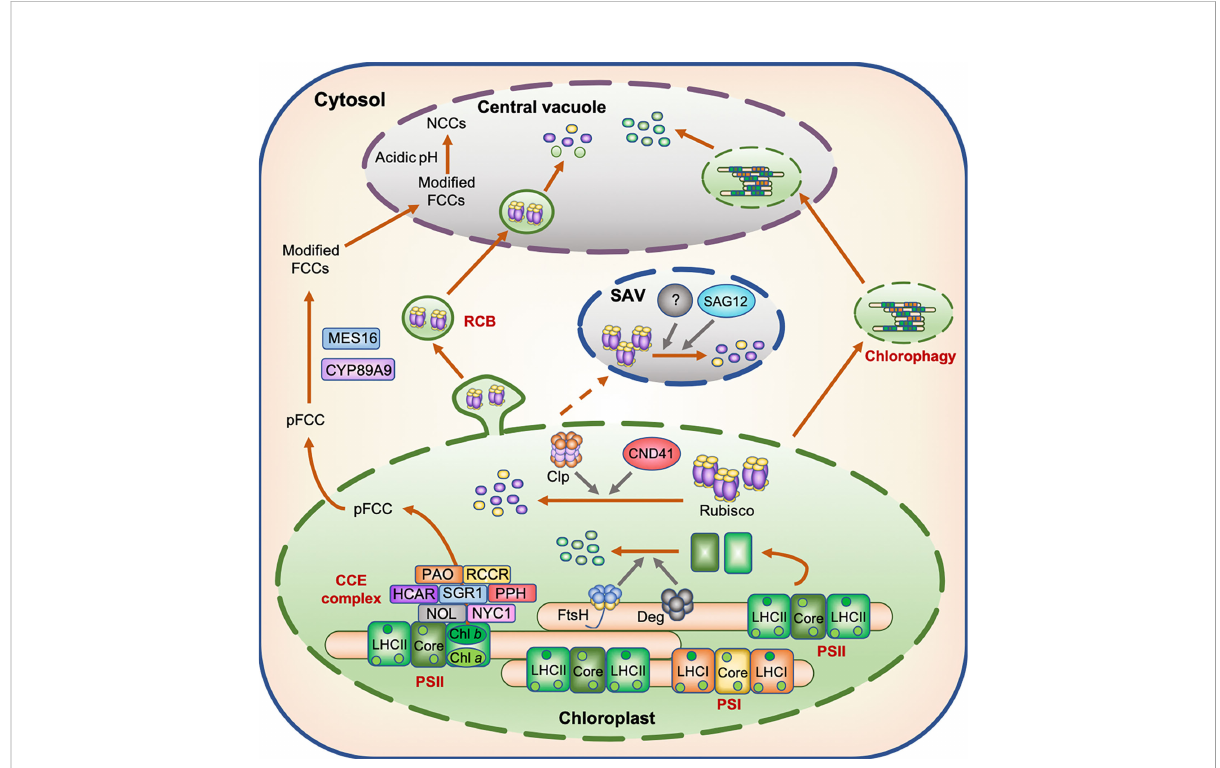
FIGURE 1 Model displaying the degradation of N-containing compounds in the chloroplast during leaf senescence. During leaf senescence, chloroplast proteins including Rubisco and photosystem subunits are believed to be degraded through several proteolytic processes mediated by proteases localized in the chloroplasts, senescence-associated vacuoles (SAVs), and central vacuoles as well as by Rubisco-containing bodies (RCBs) and chlorophagy. The degradation of chlorophyll molecules occurs in two distinct phases; the fi rst phase is associated with the degradation of chlorophyll molecules by the chloroplast-localized chlorophyll catabolic enzyme (CCE) complex, while the second phase is associated with the translocation of colorless chlorophyll catabolites fl uorescent chlorophyll catabolite (FCC) from chloroplasts to the central